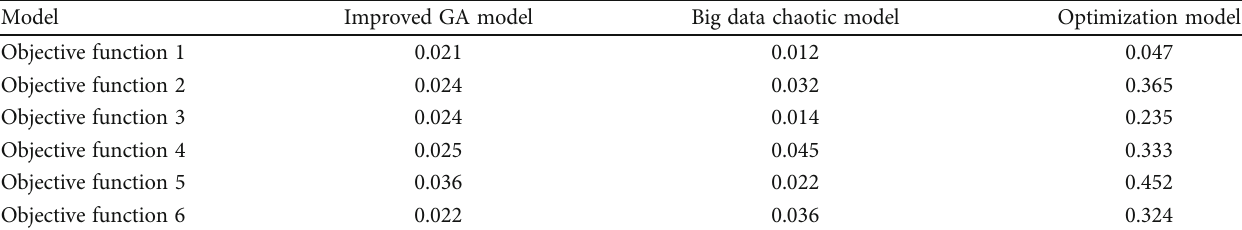
Table 1: Computational comparison of main